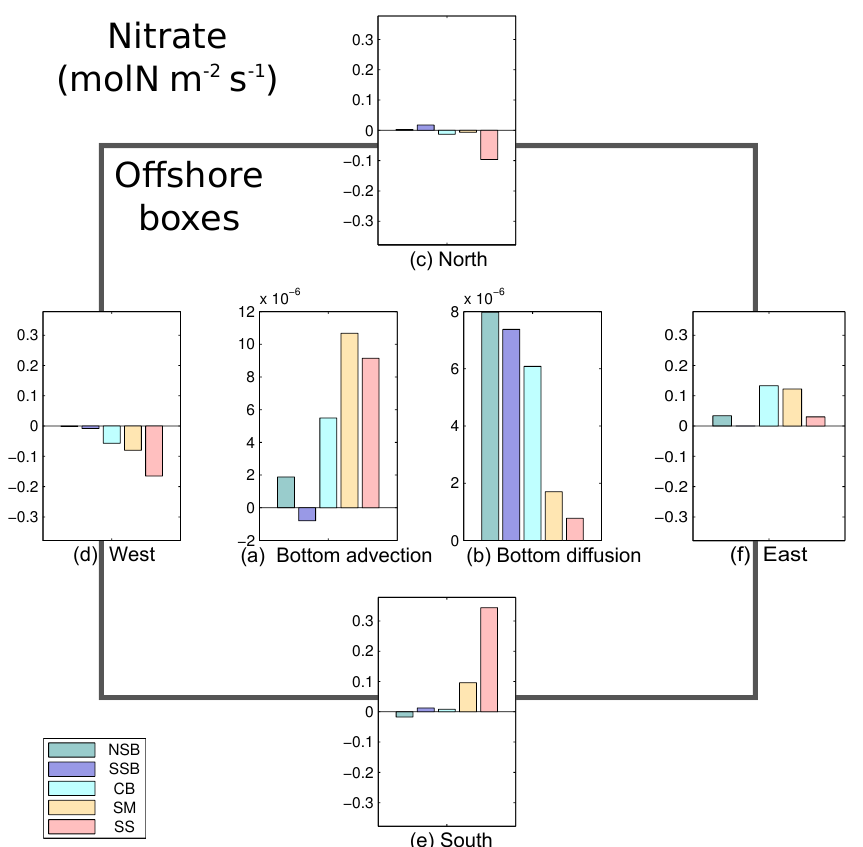
Figure 9. Spring mean (March–May) of vertical nitrate fluxes at the bottom of the offshore boxes by (a) advection and (b) diffusion (vertical mixing) and (c–f) lateral fluxes at the (c) northern, (d) western, (e) southern and (f) eastern boundaries (defined as positive inward and upward) (mol Nm − 2 s − 1 ) . Each colour corresponds to a box (see legend): northern Saharan Bank (NSB), southern Saharan Bank (SSB), Cape Blanc area (CB), Senegalo-Mauritanian region (SM) and southern Senegal region (SS).